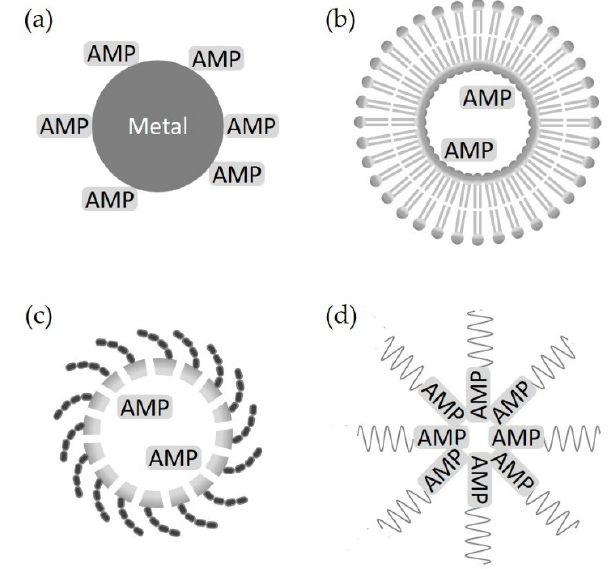
Figure 5. Nanodelivery system. ( a ) Metal nanoparticles conjugated with AMPs, ( b ) lipid-based nanoparticles conjugated with AMPs, ( c ) polymeric-based nanostructure with encapsulated AMPs, and ( d ) self-assembled AMPs.